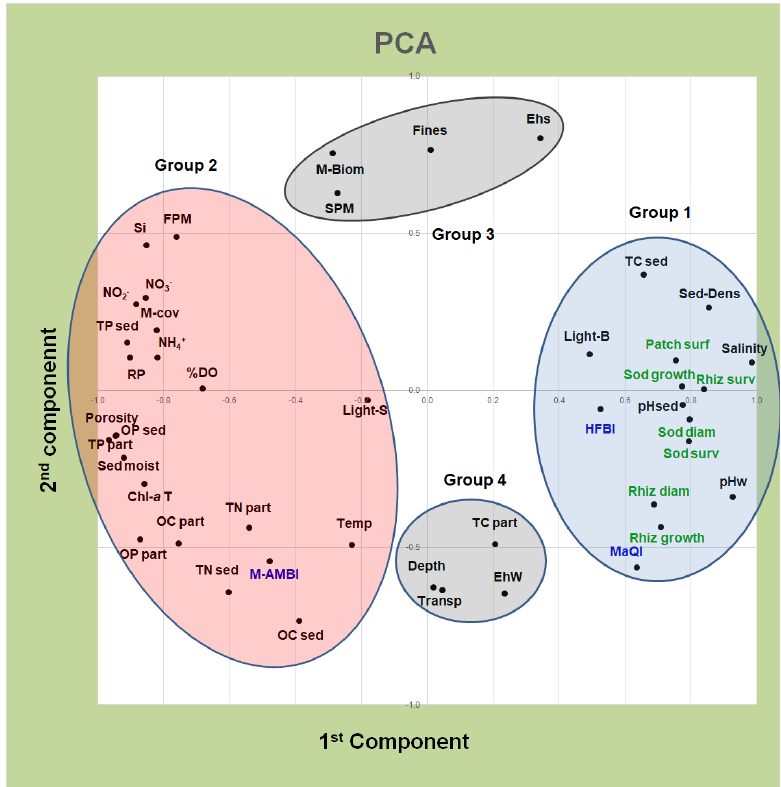
Figure 9. Principal component analysis (PCA) between physico-chemical parameters and macrophyte variables. Legend: Rhiz = rhizomes, Surv = survived, Diam = diameter, surf = surface, Temp = water temperature, Transp = water transparency, %DO = percentage of dissolved oxygen, w = water, sed = sediment, dens = density; moist = moisture, Light-S = light at a depth of −5 cm, Light-B = light at bottom, FPM = filtered particulate matter, Si = silicates, RP = reactive phosphorus, NH 4+ = ammonium, NO 2− = nitrites, NO 3− , = nitrates, DIN = dissolved inorganic nitrogen, M-Biom = macroalgal biomass, M-cov = macroalgal cover, Chl -a T = total chlorophyll- a , TP = total phosphorus, OP = organic phosphorus, TN = total nitrogen, TC = total carbon, OC = organic carbon, SPM = settled particulate matter, part = particulate.